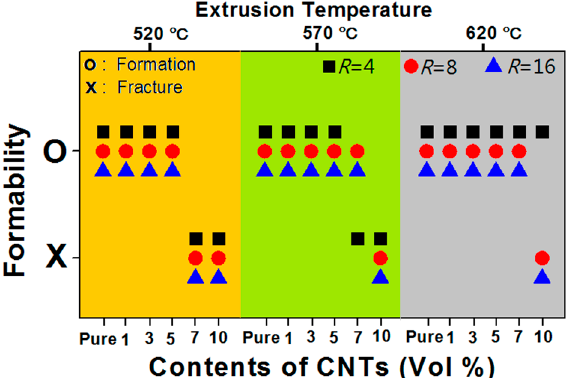
Figure 6. Formability for temperatures and ratios of extrusion (O: formation, X: fracture).